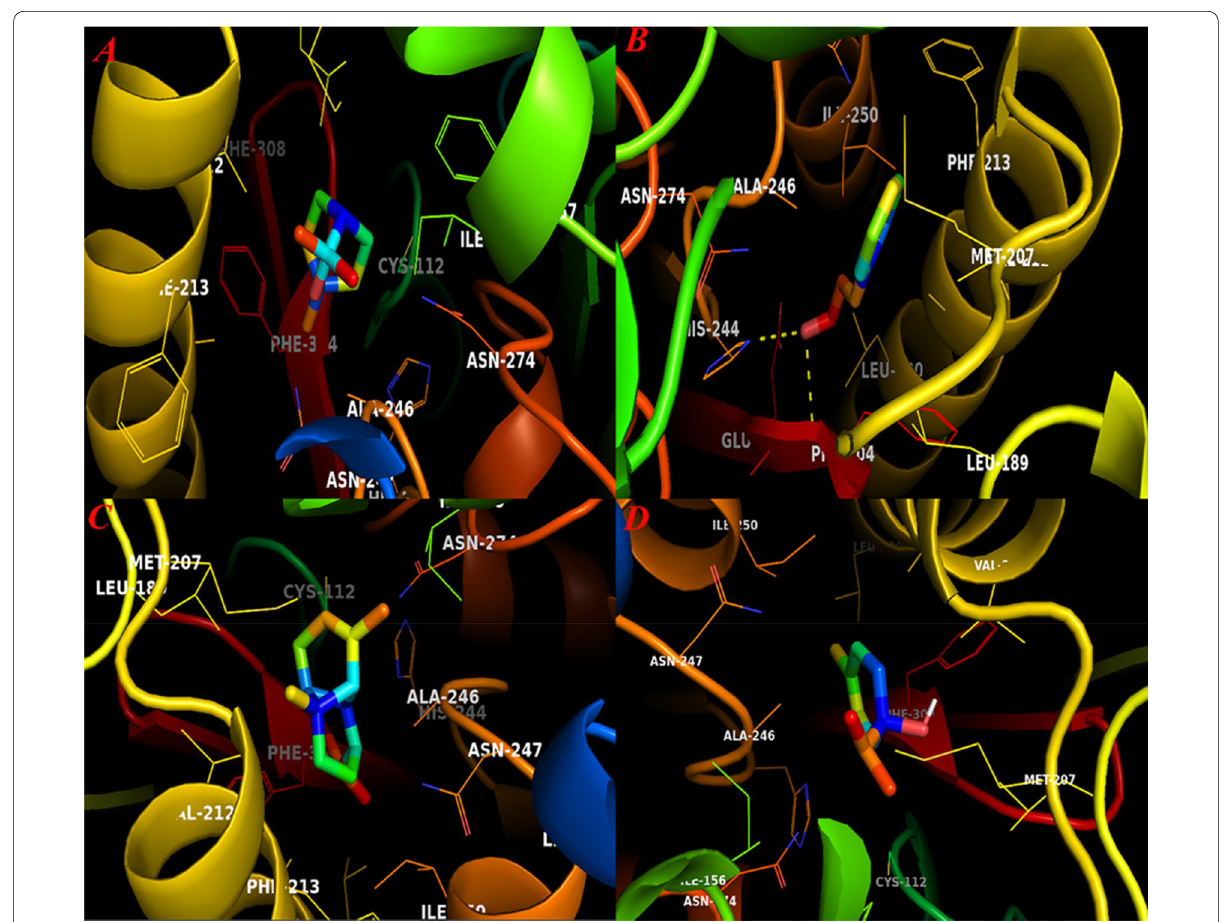
Fig. 4 The graphical illustration of docked ligands and β-Ketoacyl-Acyl Carrier Protein Synthase III. A 1,8-cineole; B E -Cinnamaldehyde; C Copaene and D